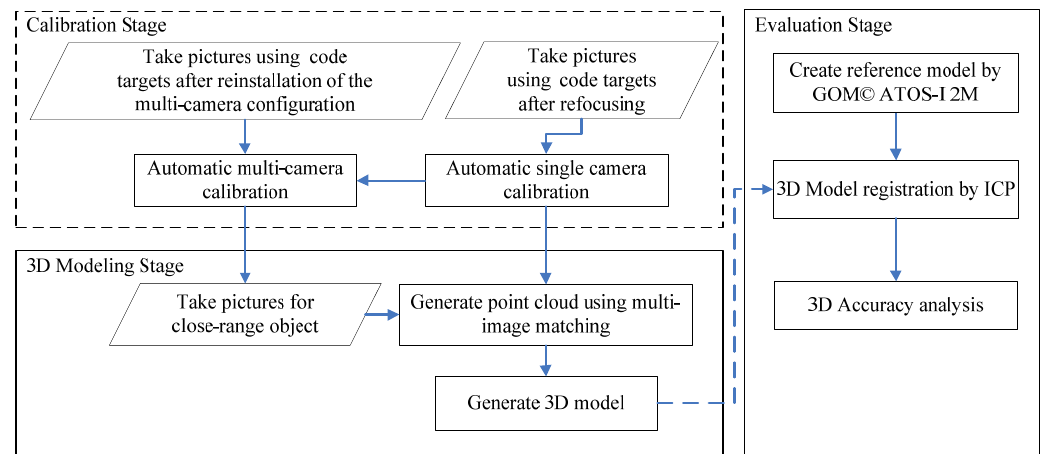
Figure 1. The flow-chart of the proposed 3D modeling